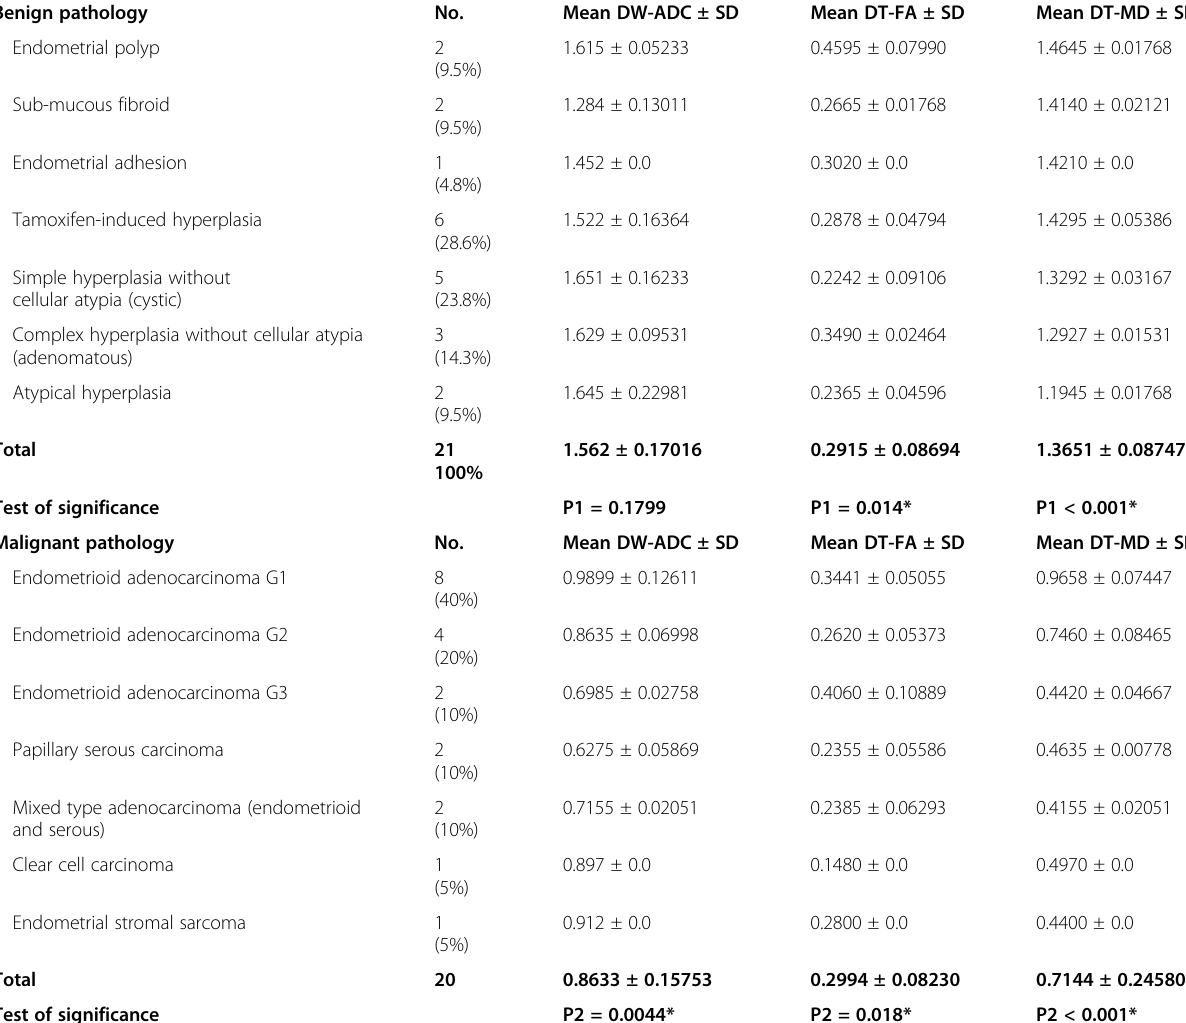
P1: for differentiation between different benign lesions. P2: for differentiation between different malignant